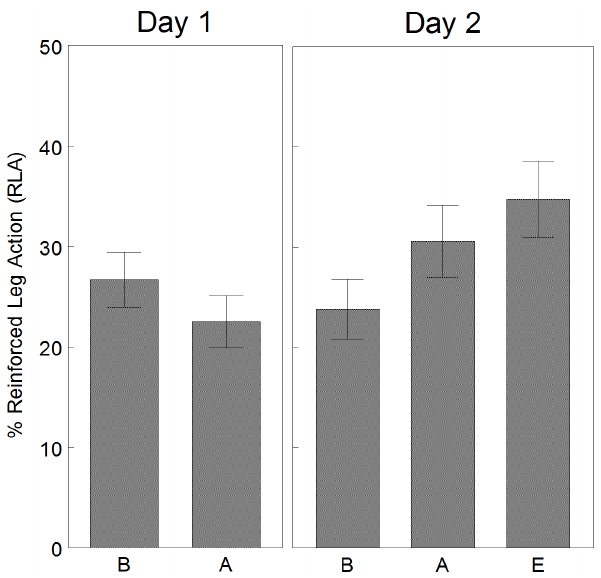
Figure 5. Mean percent reinforced leg action by condition. Infants (n=14) did not demonstrate a significant change across conditions. Error bars are standard error. B=baseline, A=acquisition,